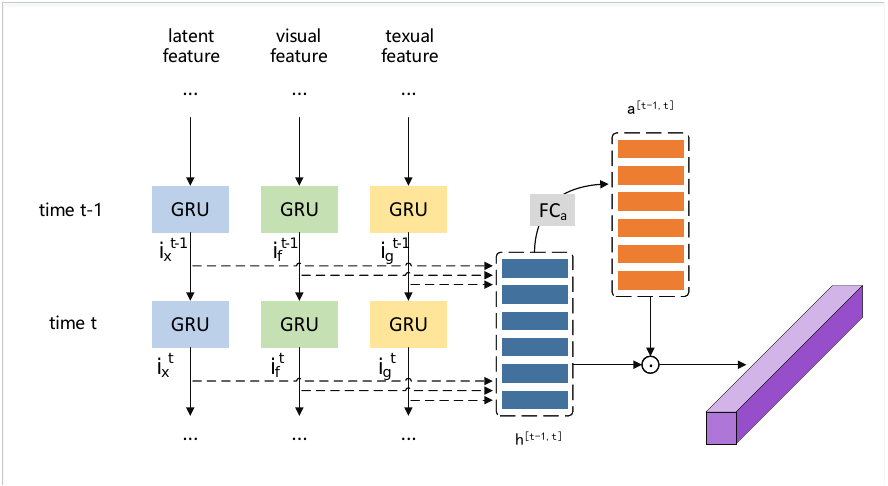
Figure 1. The framework of the proposed MFN4Rec